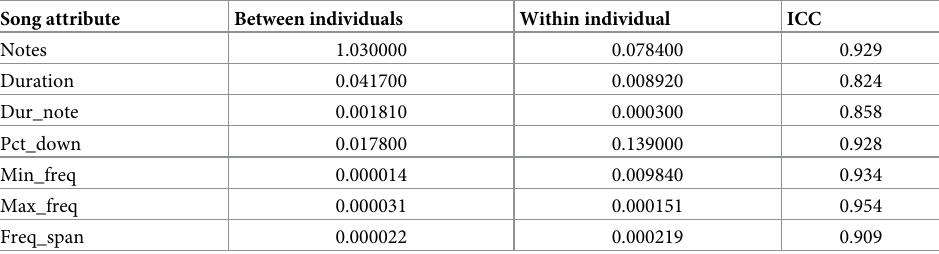
Table 4. Variance components and Intra-Class Correlation (ICC) for within- and between-song variation in Loui- siana Waterthrushes. Song attribute Between individuals Within individual ICC